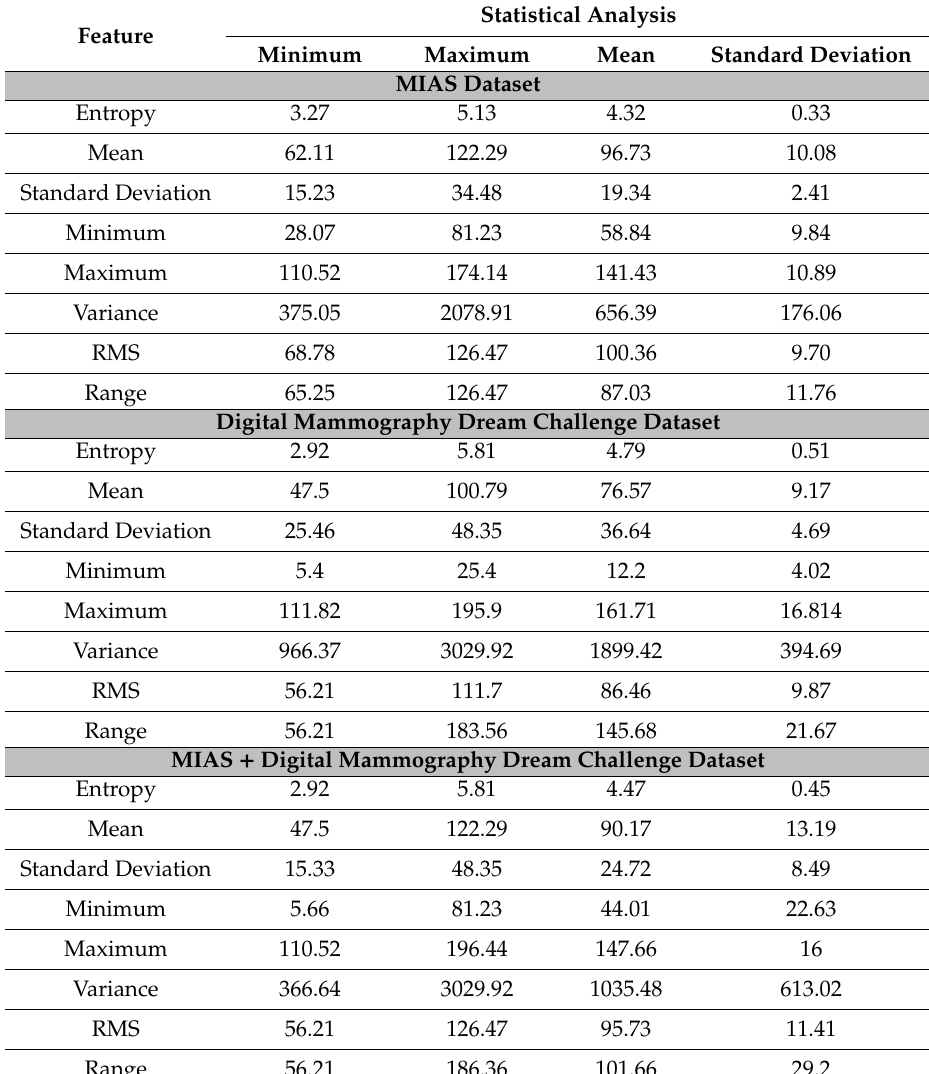
Table 13. Statistical analysis for each feature of the breast cancer